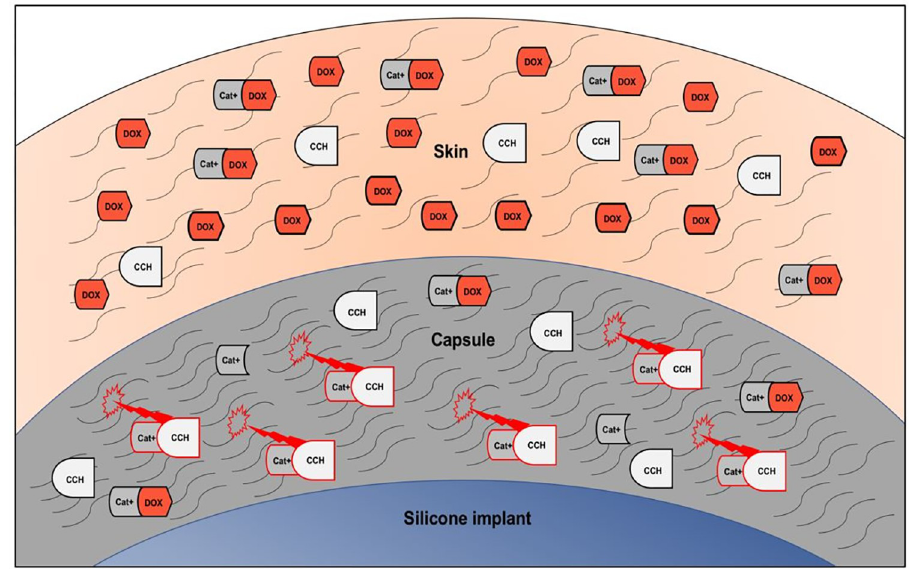
Fig 1. Postulated mechanism of action. Schematic description of the potential mechanism of action for skin protection after CCH-injection through doxycycline. CCH (collagenase of the bacterium C. histolyticum) needs to bind metal cations (Cat+) for active degradation of collagen, which is the main component of the fibrotic capsule around silicone implants. Doxycycline (DOX) accumulates in the skin and acts as a metal cation chelator. CCH- molecules diffusing into the skin from the capsule are inactivated, due to the competitive binding of Cat+ to DOX- molecules. This leads to reduction of CCH-induced collagen degradation in the skin and thus protection from CCH- related skin